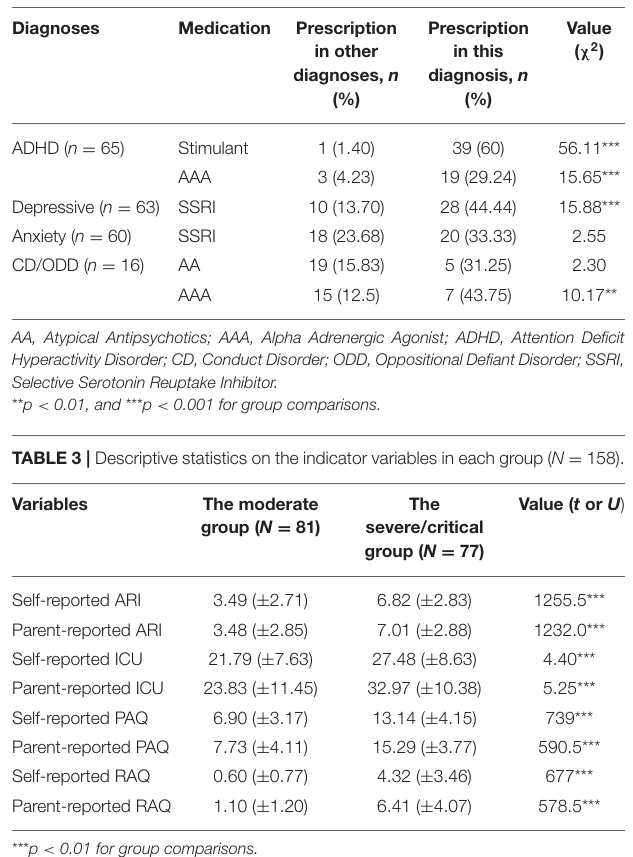
TABLE 4 | Differences in socio-demographic and diagnosis between two Latent Classes ( N =